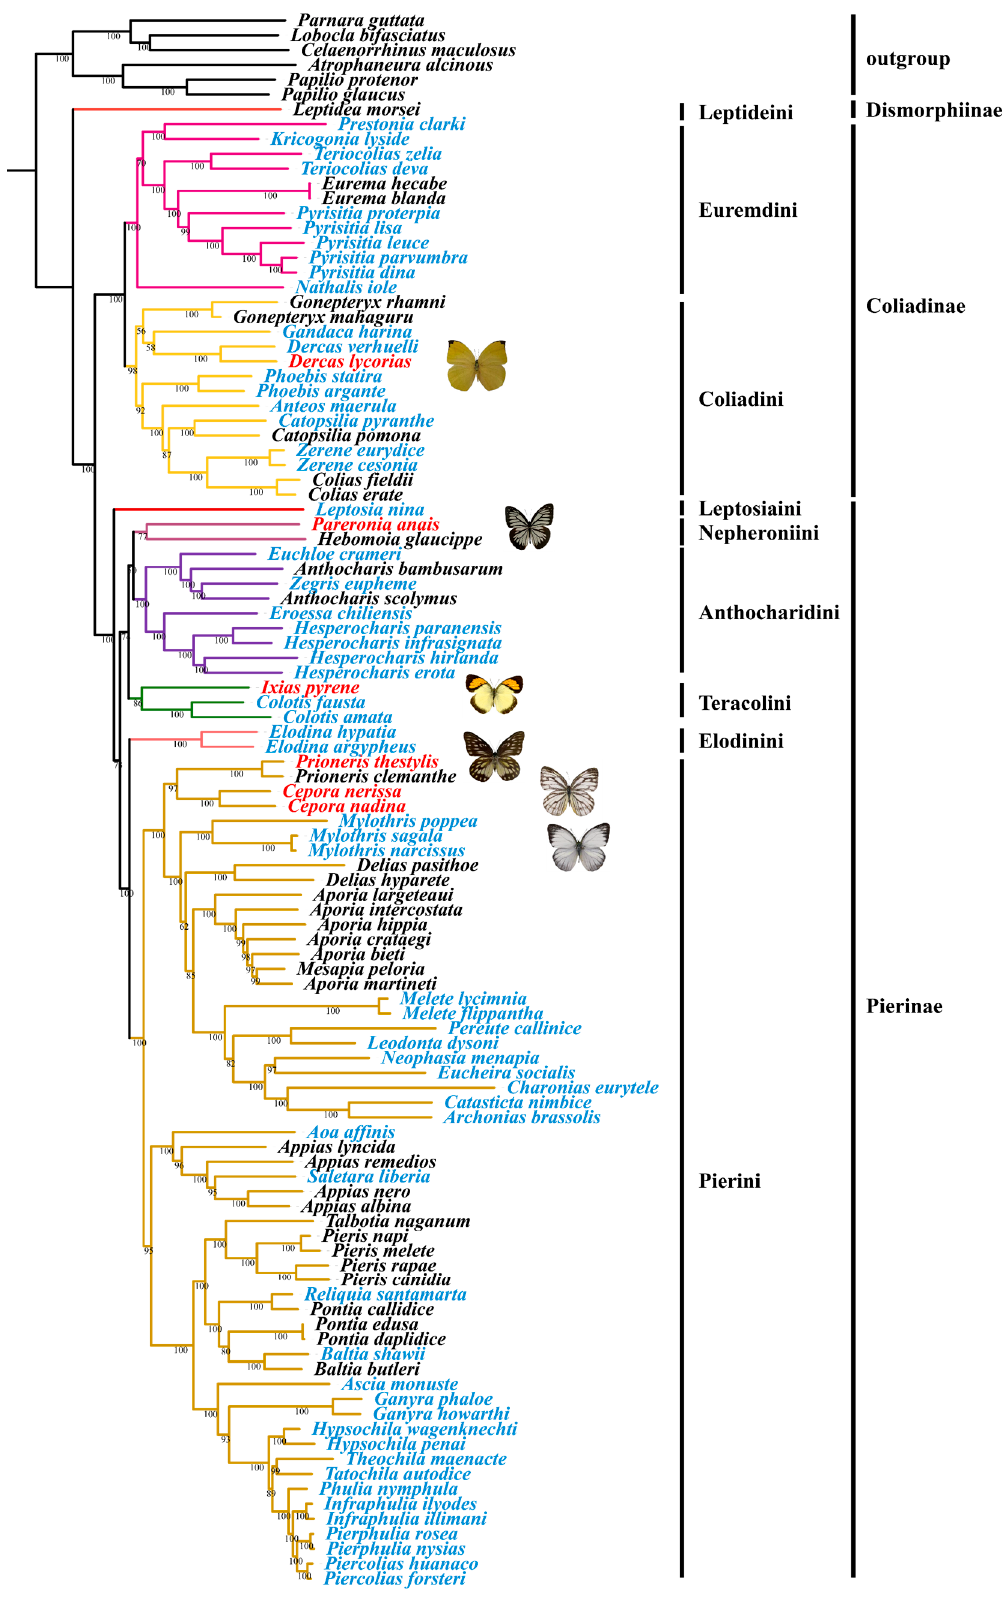
Figure 6. Phylogenetic relationships of the 100 Pieridae species from maximum likelihood (ML) analysis based on 13 mitochondrial protein-coding genes; bootstrap values are indicated at each node. The species sequenced and extracted from the whole genome are marked in red and blue, respectively.